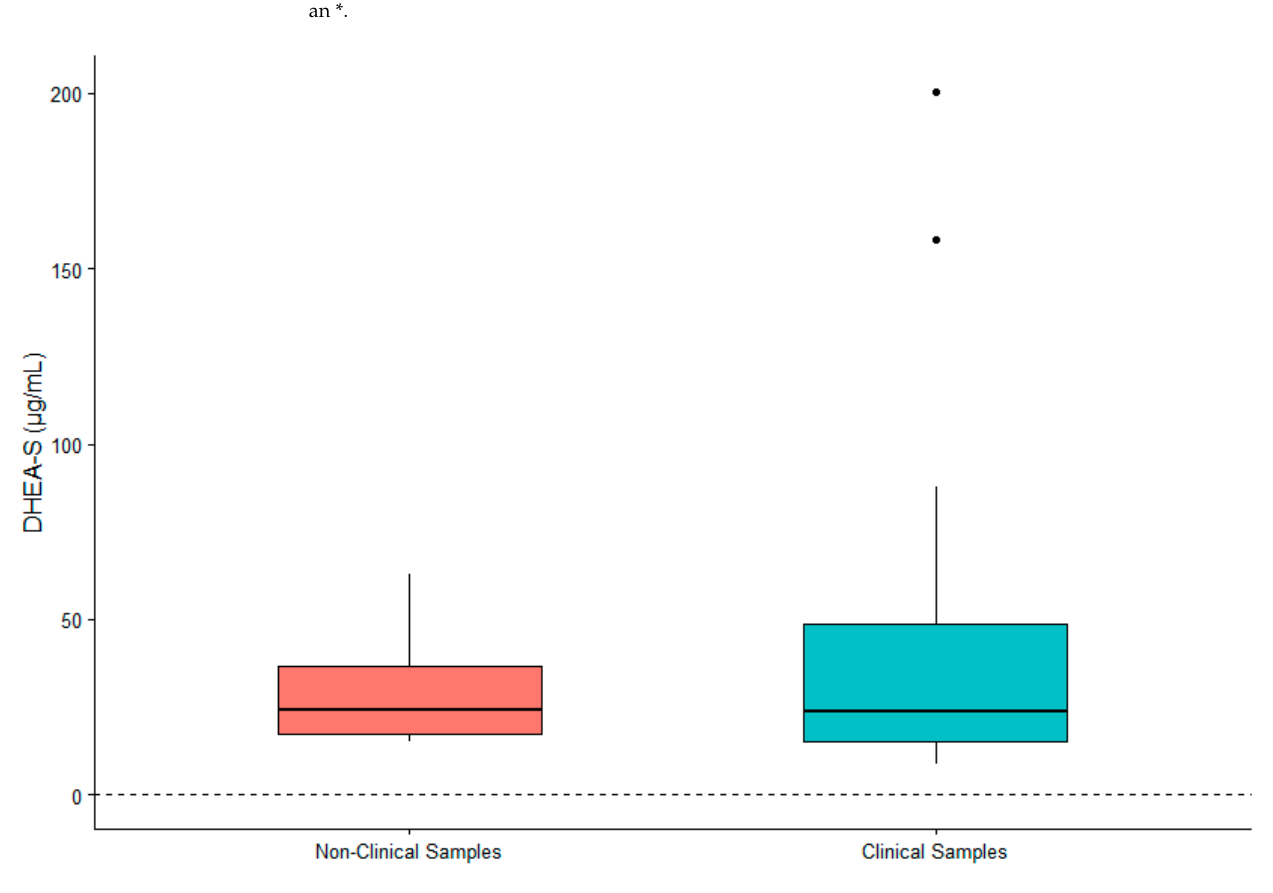
Figure 1. Differences in concentrations of serum DHEA ‐ S between non ‐ clinical and clinical western lowland gorilla ( n = 21) samples ( β = − 0.174, SE = 0.109, p = 0.110). The calculated lower limit of the species ‐ specific value range is denoted by the dashed horizontal line.